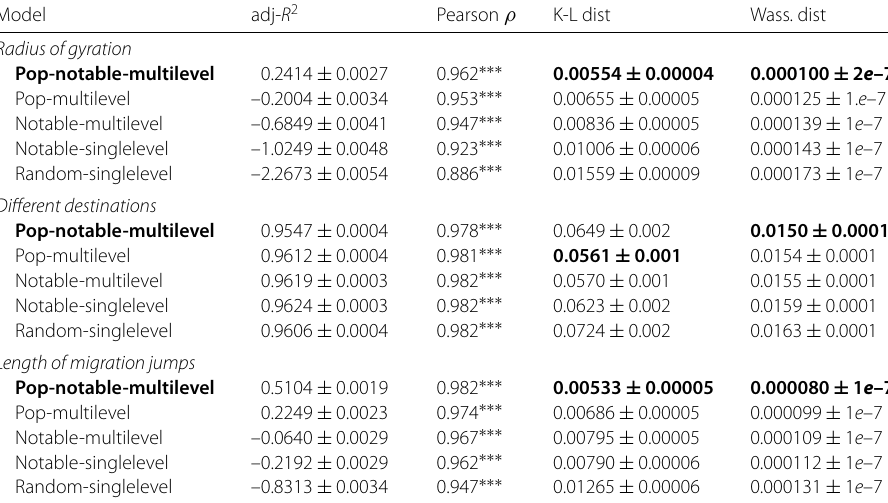
Table 4 Models’ performances. Results obtained for the five models on predicting the number of destinations, the radius of gyration, and the distribution of the length of the migration jumps. The metrics used are the adjusted- R 2 , the Pearson correlation coefficient, ρ , between models and data, the Kullback–Leibler distance (K-L dist), and the first Wasserstein distance (Wass. dist) Model adj- R 2 Pearson ρ K-L dist Wass.